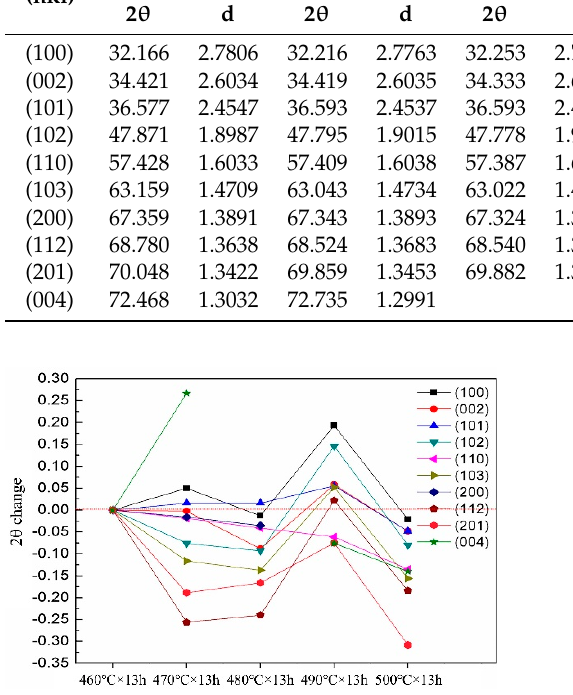
Figure 10. 2 θ change.